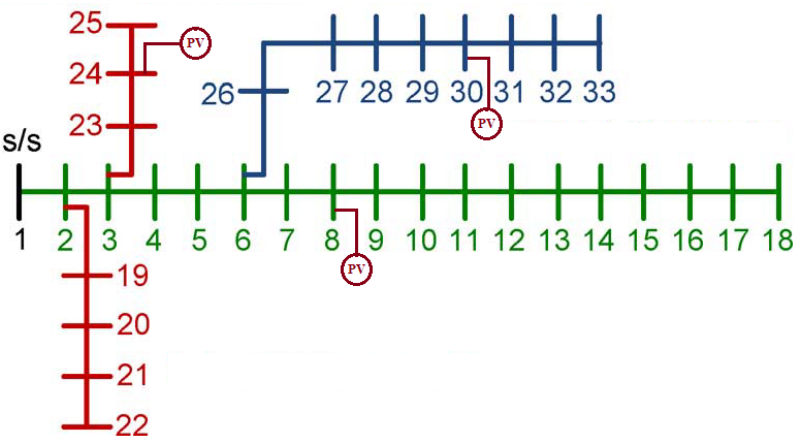
Figure 5. IEEE 33 radial distribution network.